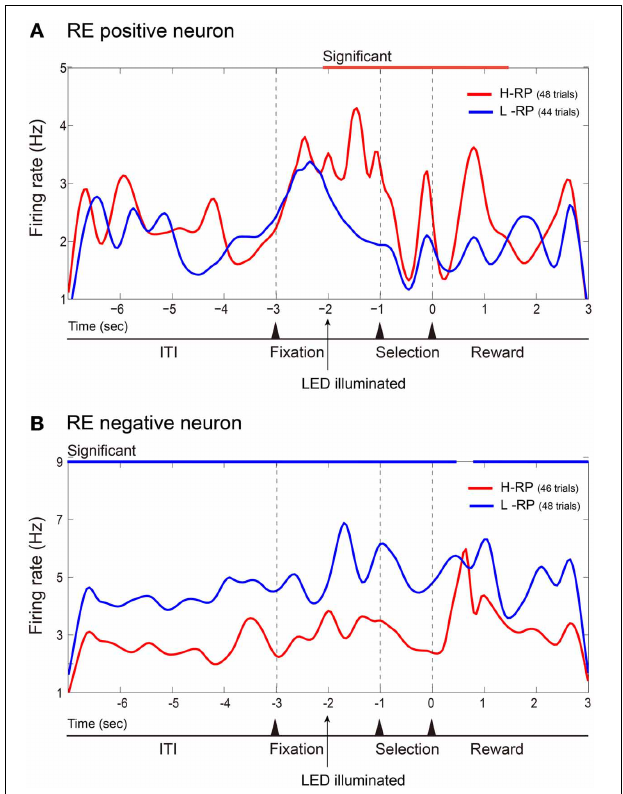
FIGURE 3 | Examples of amygdala RE neurons. Firing rates in all correct trials of a session are cumulated and smoothed separately under the H-RP and L-RP conditions. (A) Example of RE positive neuron, which fired more frequently for the rat under the H-RP condition than the L-RP condition. The time of zero is the time when the rat poked its nose into the selected hole. The period of significantly ( p < 0 . 05) higher firing rate under the H-RP condition is indicated by the red horizontal line at the top of the graph. (B) Example of RE negative neuron, which fired more frequently for the rat under the L-RP condition than the H-RP condition. Periods of significantly ( p < 0 . 05) higher firing rates under the L-RP condition are indicated by the blue horizontal lines at the top of the